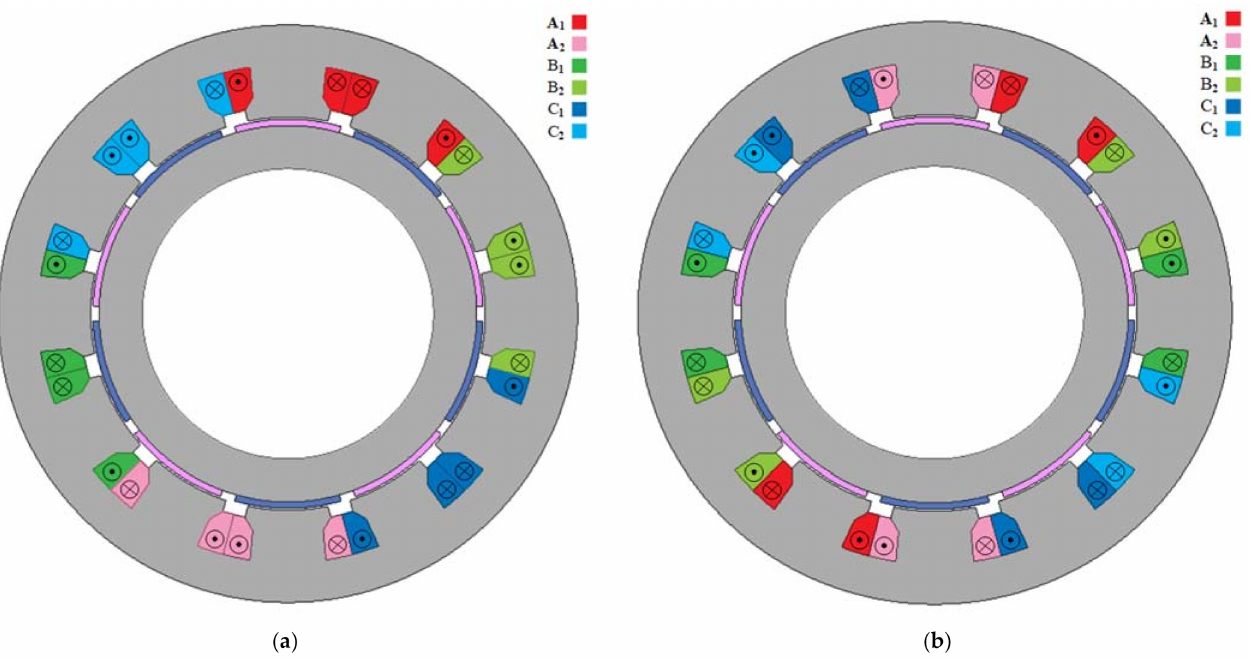
Figure 2. Six-phase 12-slot/10-pole surface-mounted permanent magnet (SPM) winding arrangements: ( a ) Dual three-phase and ( b ) asymmetrical six-phase.